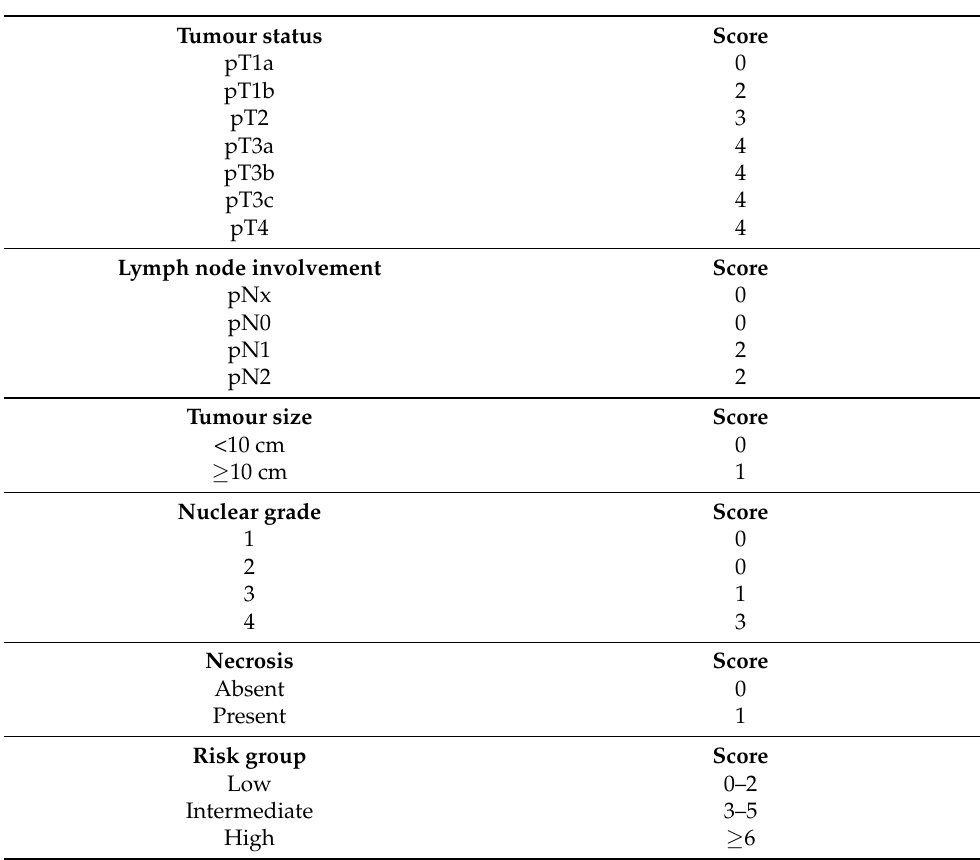
Table A1. Leibovich score